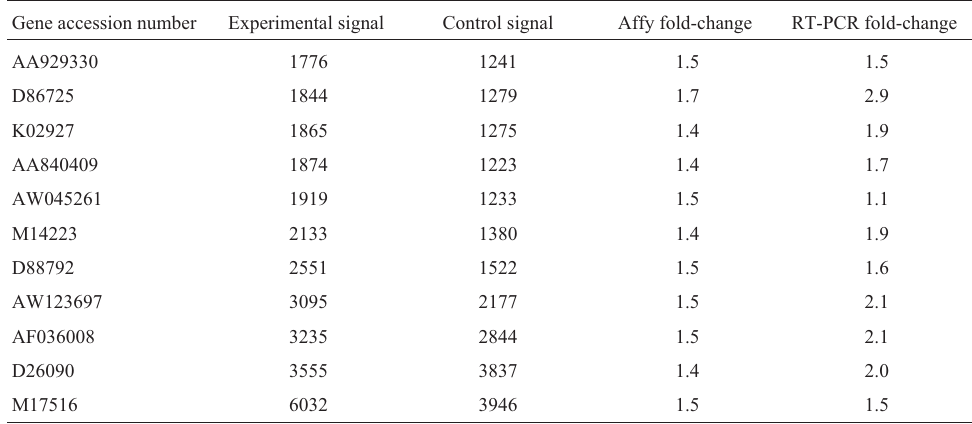
Table 2 - Validation of significant changes identified by signal thresholds. All genes have no significant changes using a two-fold threshold but have significant changes by using signal thresholds. Ten out of the eleven genes have ≥ 1.5 fold-change by quantitative